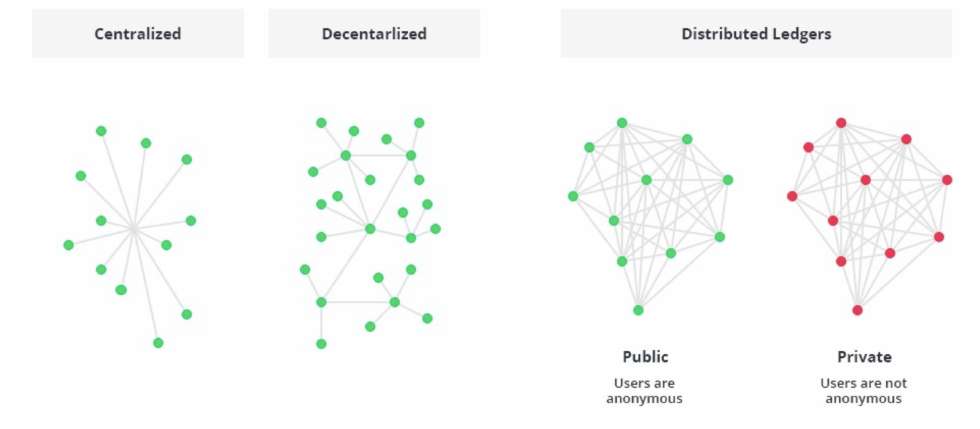
Figure 2. Blockchain